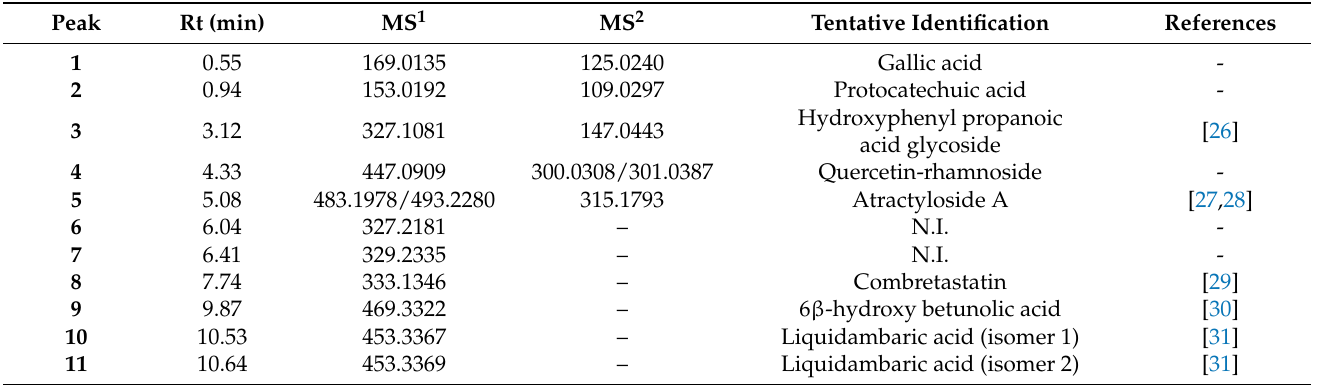
Figure 3. Chromatographic profile of S-EA fraction obtained on LC-MS analysis. Table 2. Putative identification of the compounds observed on S-EA fraction obtained on LC-MS